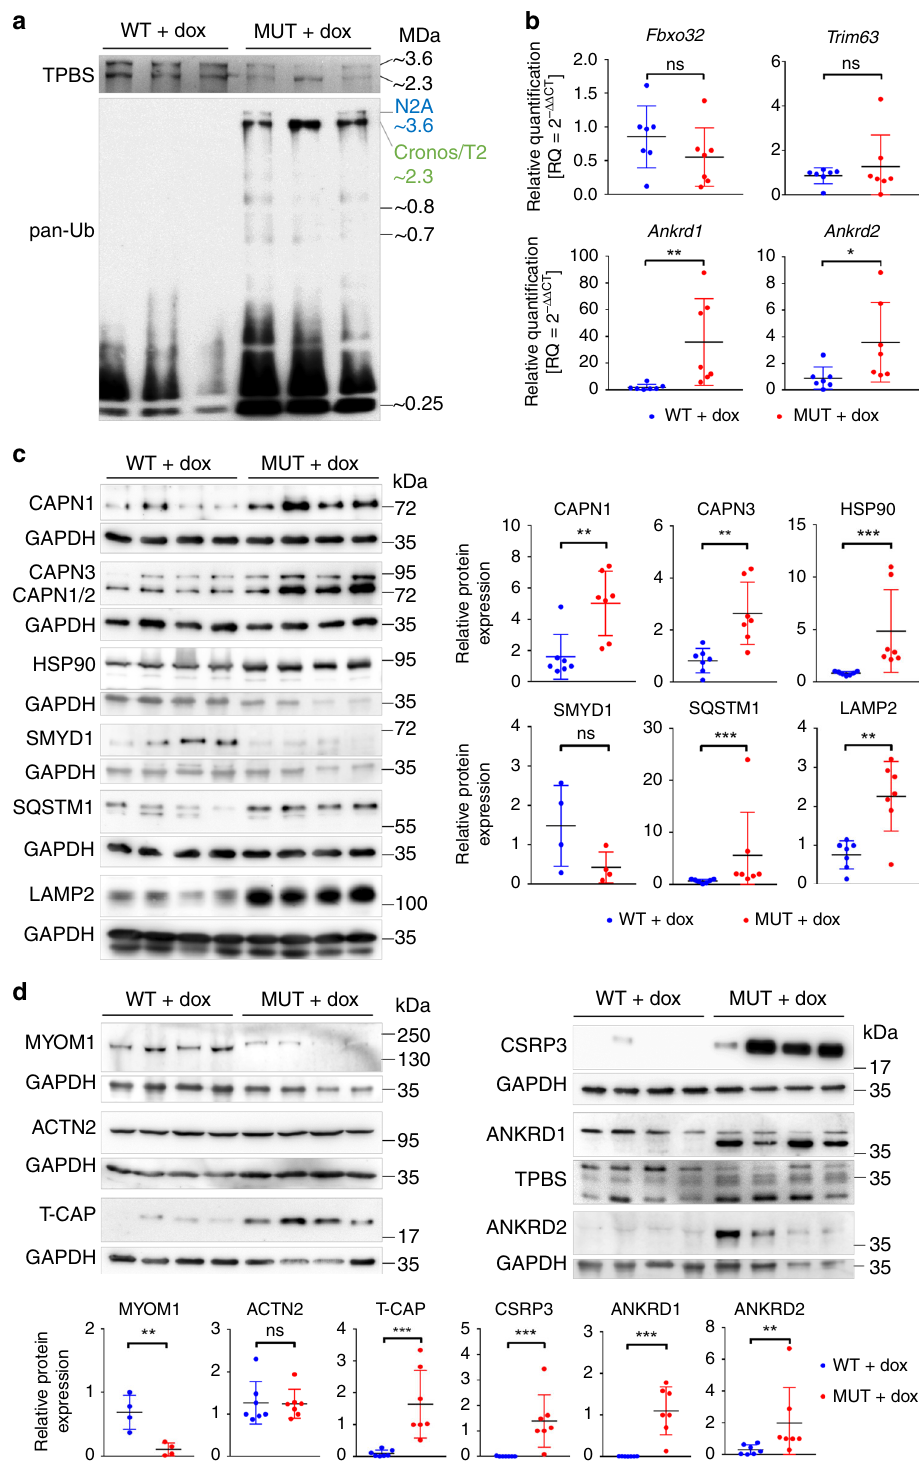
Loss of TTN activates the PQC machinery . Sarcomere-bound E3-ubiquitin ligases have been implicated in muscle atrophy, band-associated (TTN-binding) Trim63 (MuRF1) 32 . However,